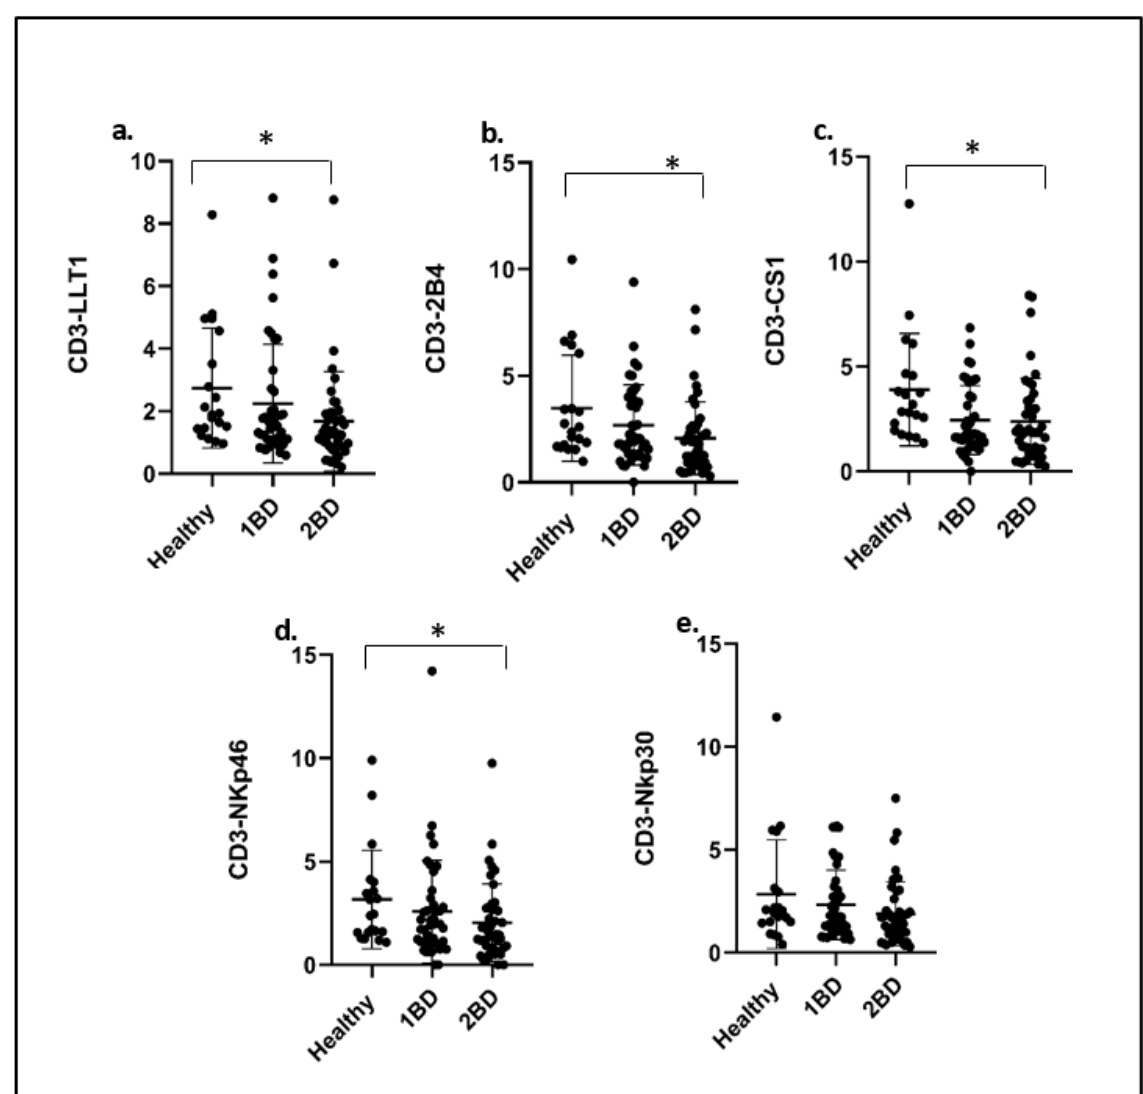
Figure 4. Expression of LLT1, 2B4, CS1, NKp30 and NKp46 expression on T cells (CD3+) of ALL subjects. ( a – e ) Flow cytometry analysis exhibits the cell surface expression of indicated receptors on T cells of ALL subjects compared to healthy subjects indicated by the median fluorescence intensity ratio (MFIR). 1BD, first blood draw indicates sample obtained at diagnosis (day 0). 2BD, second blood draw indicates sample obtained at the end of induction chemotherapy (day 29). * p < 0.05.